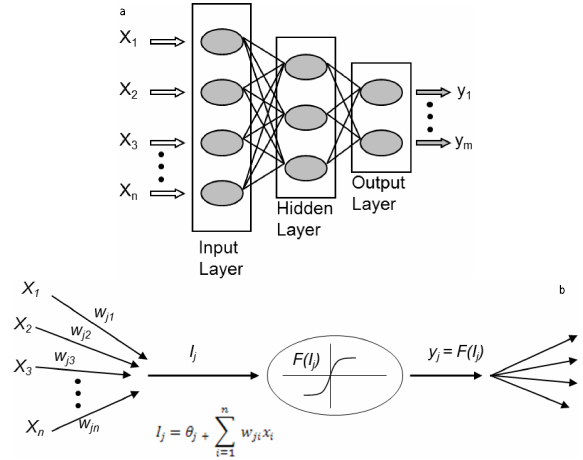
Fig. 10. Comparison between HEM inversions without and with a- priori constraints from ECPTs. Location of cross section is C-C’, see Fig. 1.